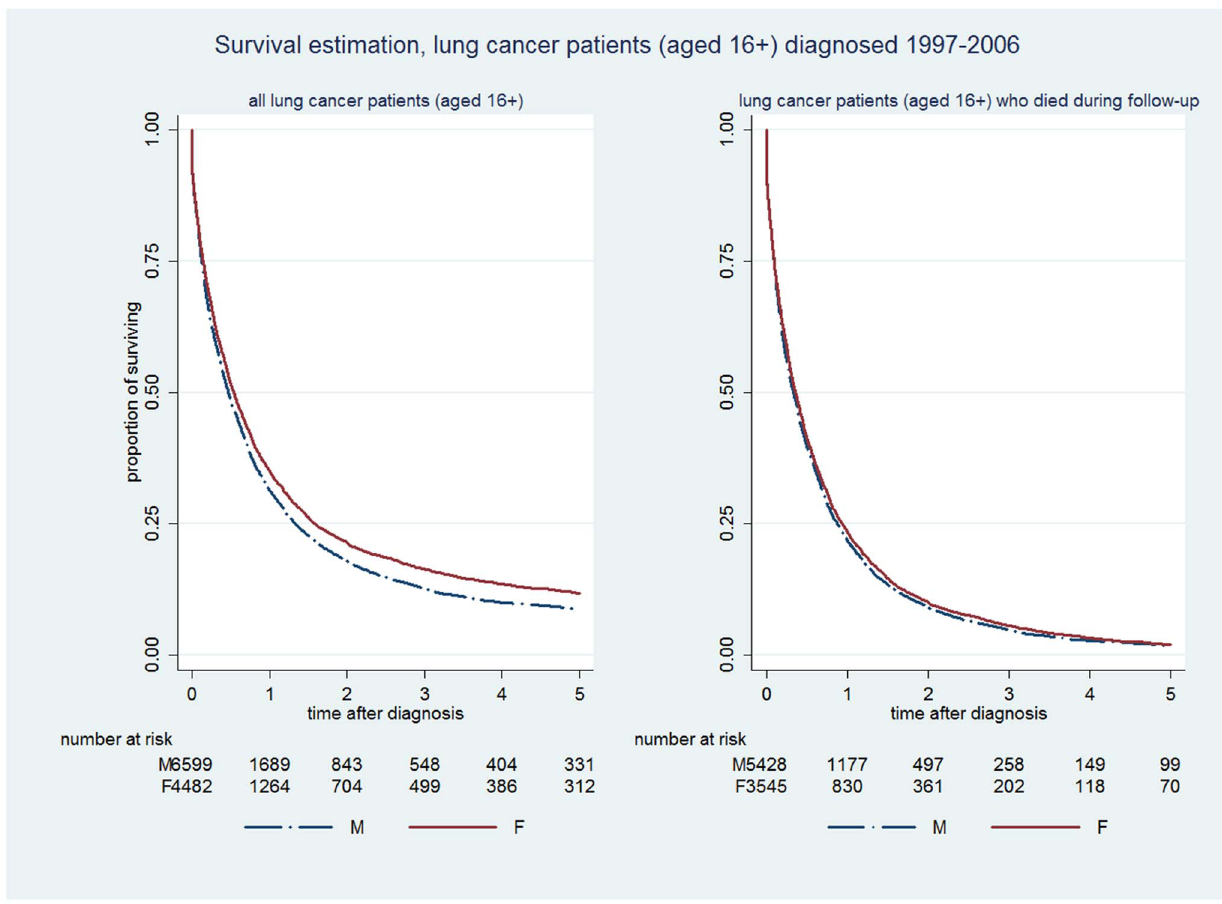
Figure 2. Kaplan-Meier survival curves for lung cancer patients (diagnosed between 1997–2006).